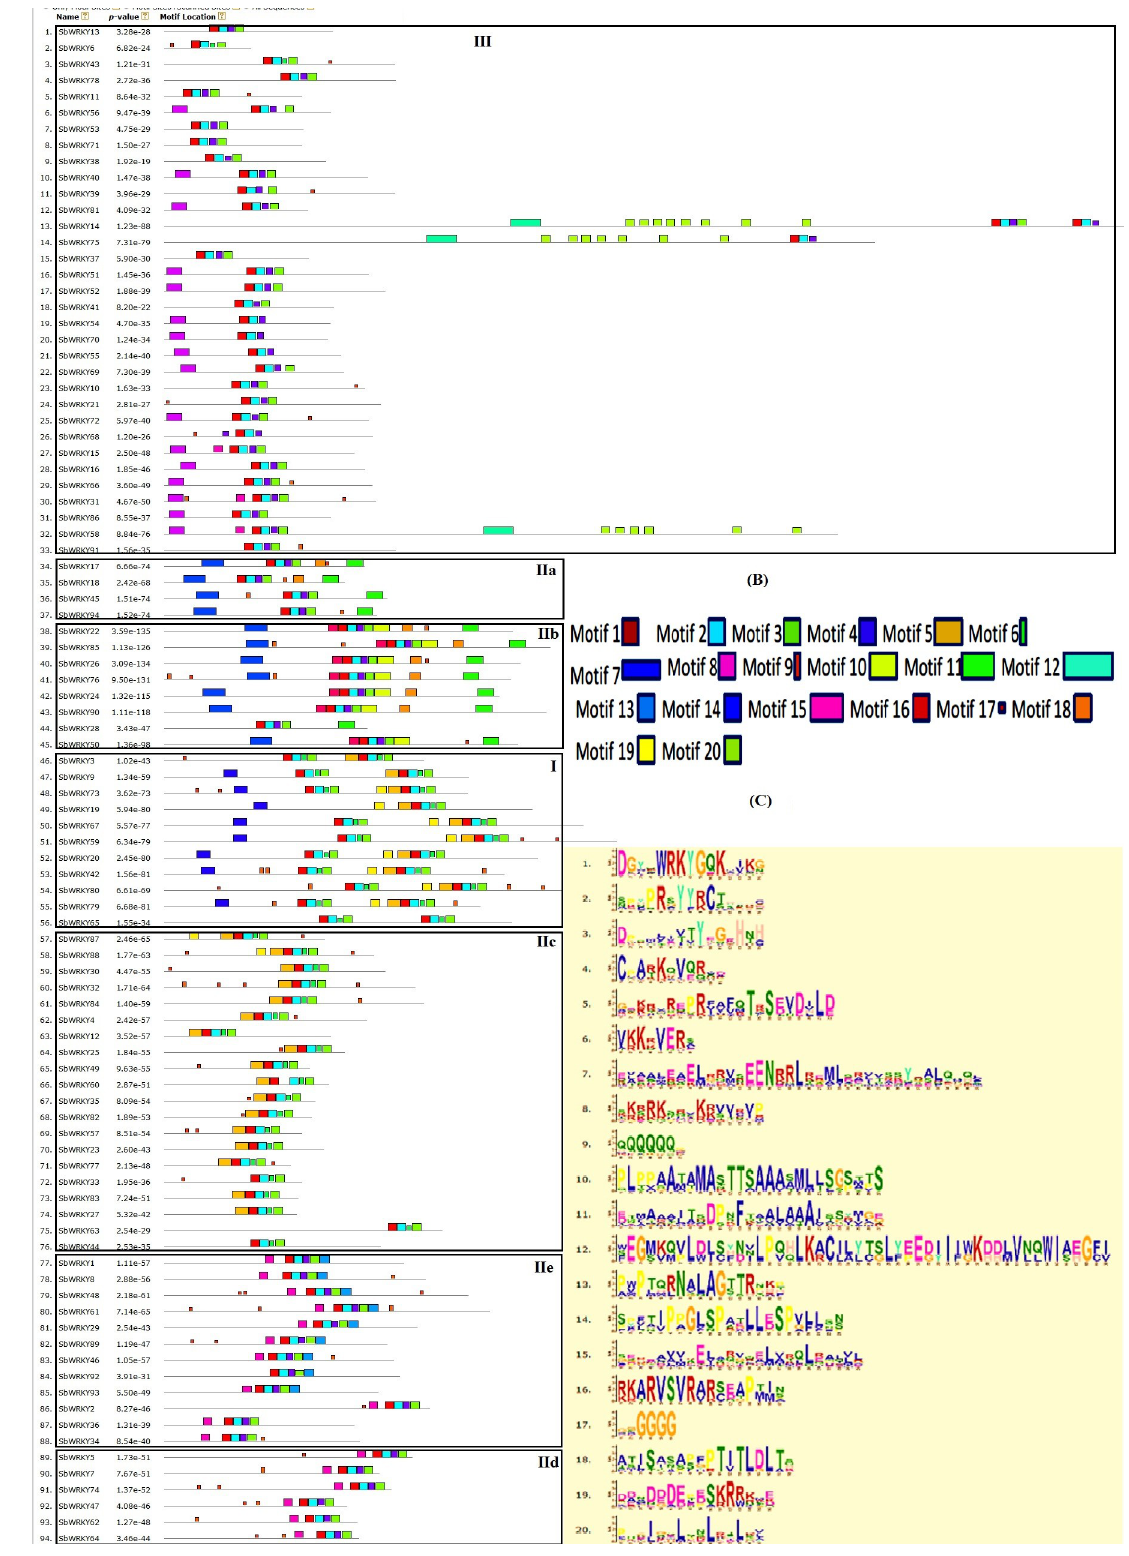
Fig 4. Motif analysis of Sb WRKYs. (a) The distribution of 20 conserved motifs identified by MEME in the different groups of Sb WRKYs. (b) Each motif is indicated by a different color. (c) Sequence logos for motifs 1–20. https://doi.org/10.1371/journal.pone.0236651.g004 PLOS ONE | https://doi.org/10.1371/journal.pone.0236651 August 17,